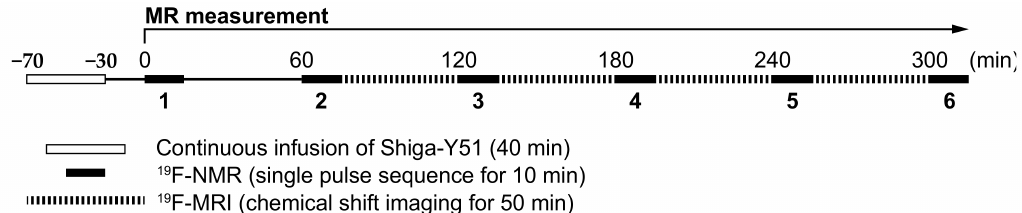
Figure 2. Timeline of the present study. Shiga-Y51 (200 mg/kg, i.v.) was injected by a continuous infusion over 40 min in APP/PS1 and wild-type mice under deep anesthesia. The first fluorine-19 nuclear magnetic resonance ( 19 F-NMR) measurement was performed 30 min after the injection and repeated every 60 min. Fluorine-19 chemical shift imaging ( 19 F-CSI) data for the fluorine-19 magnetic resonance ( 19 F-MR) images were collected for 50 min every 1 h after the second 19 F-NMR measurement.